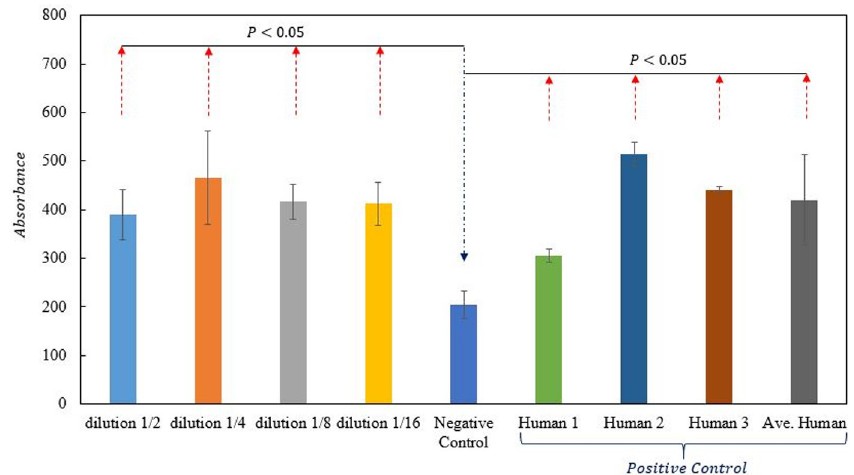
Fig 10. Comparative ELISA for three human patient serums with IgG subclass and UDA-treated plates. ELISA results from four independent experiments of binding of UDA to the RBD of SARS-CoV-2 spike protein with different dilutions, negative control, three samples of convalescent serum IgG from patients, average of results of patient samples as positive control. https://doi.org/10.1371/journal.pone.0268156.g010 of 10 hydrogen bonds by Gln493, Ser494, Tyr495, Gly496, Phe497, Gln498, Thr500, Asn501, Gly502 and Tyr505 in this region of RBD with UDA. In the study of Sayan Batacharaji et al. [30] comparison of RMSF plots of free RBD and ACE2-bound RBD illustrate that ACE2-- bound RBD plot decreases simultaneously in the dynamics of loop 474–486 and loop 358–376, possibly due to allosteric involvement of loop 358–376 through correlated motion. These observations also occurred in both RBD-UDA and RBD-ACE2 simulations in our study. It is generally observed that the fluctuations of the RBD-UDA plot are less than other plots (Fig 6). After 100ns of simulation, the RBD residues in binding formation are Phe456, Tyr489, Gln493, Gly502, Asn501, Tyr505, Tyr453, Lys417, Gln498, and Thr500, which it shows the RBD-UDA complex is stable in 100 ns. From the distance plot, it was observed that RBD does